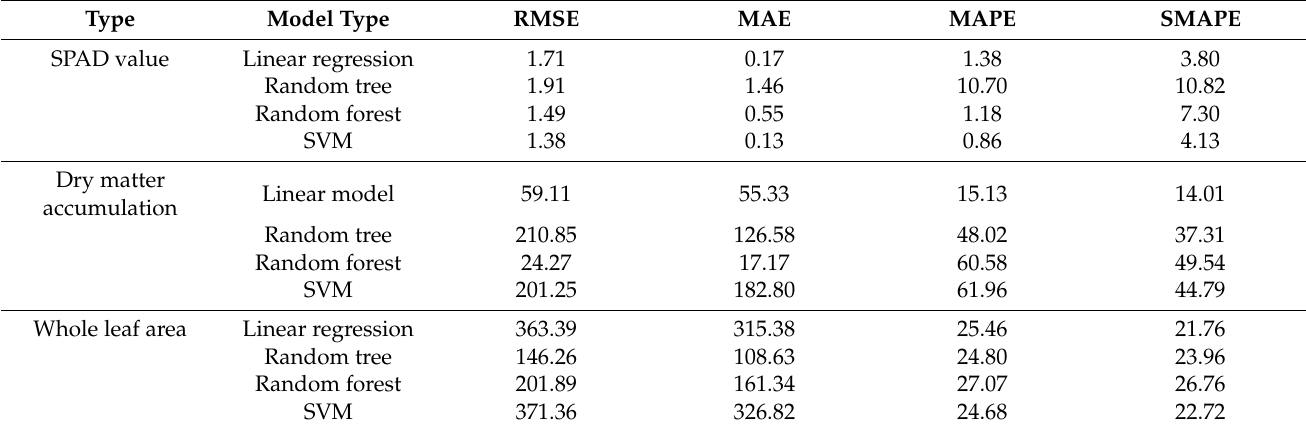
Table 6. Comparison of prediction accuracy of multi-factor regression